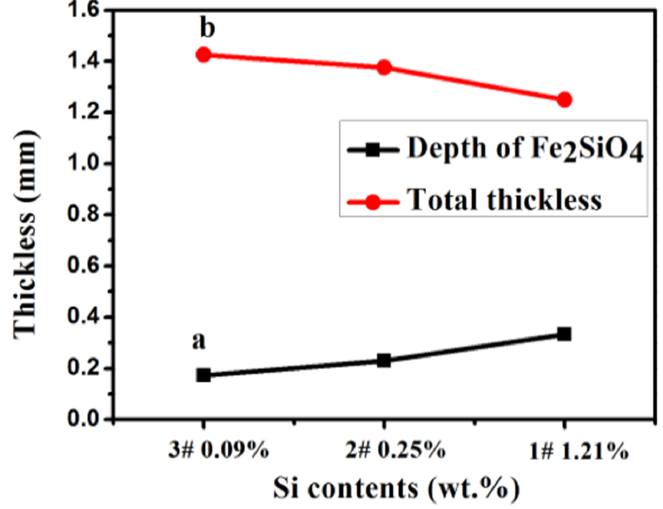
Figure 6. The penetrative depth of fayalite (Fe 2 SiO 4 ) and total scale thickness in three different silicon ‐ content steels.